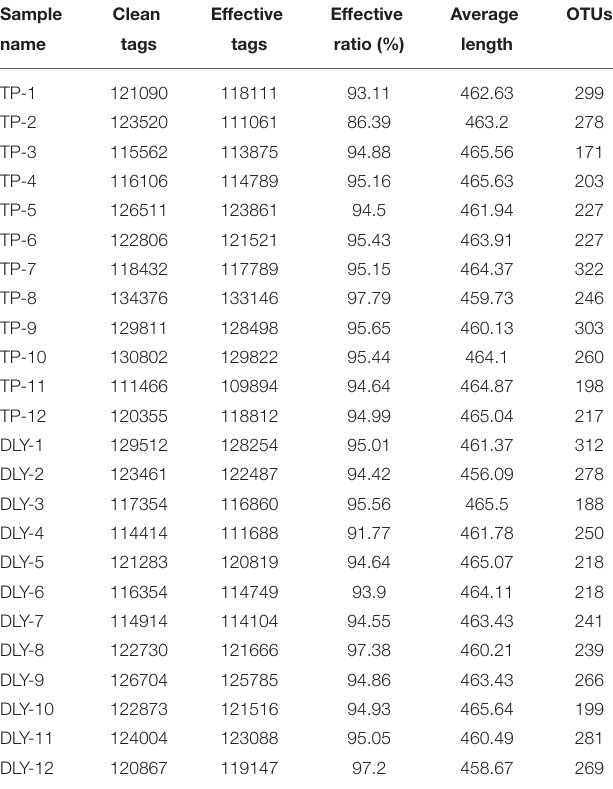
TABLE 4 | Original data sheet of jejunal microorganism 16S rRNA gene sequencing. Sample